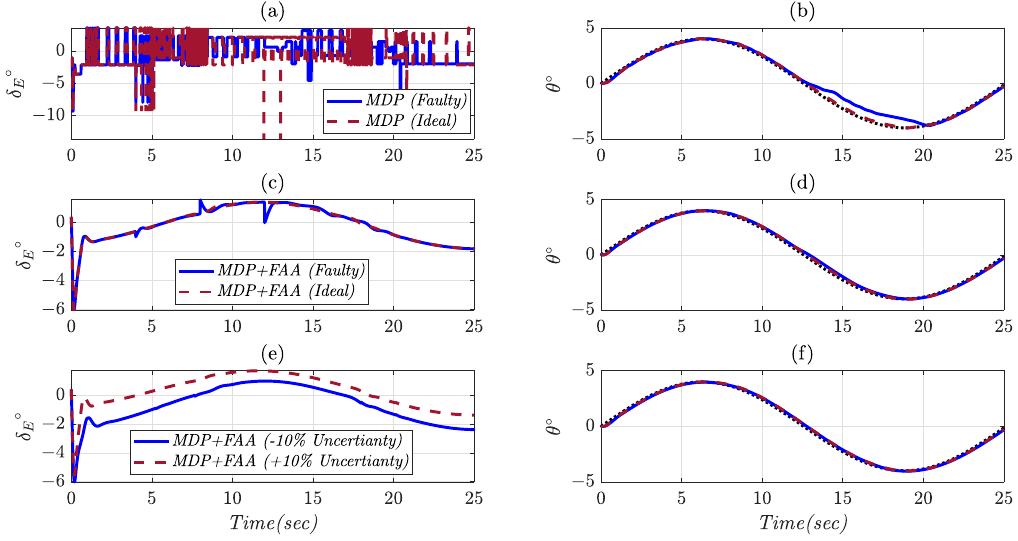
Figure 10. ( a ) Elevator deflection of basic MDP Q-learning in faulty and ideal flight conditions; ( b ) Pitch angle tracking related to ( a ). ( c ) Elevator deflection of FAA-improved Q-learning in ideal and faulty conditions; ( d ) Pitch angle tracking related to ( c ). ( e ) Elevator deflection of FAA-improved Q-learning in the presence of ± 10% model uncertainties; ( f ) Pitch angle tracking related to ( e